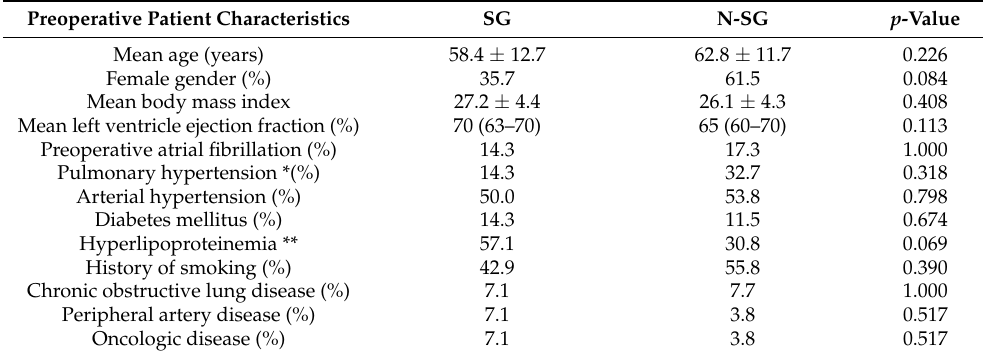
Table 1. Preoperative patient characteristics.